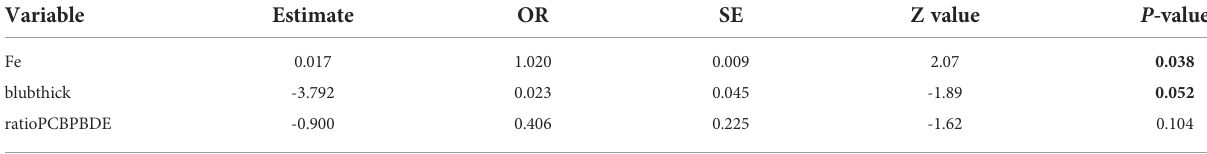
TABLE 2 Maximum-likelihood estimates and odds ratio (OR) from fi tting fi nal conditional logistic regression model for a case-control study, matched on age class, to evaluate variation in mucormycosis status (case or control) associated with iron (Fe), blubber thickness (cm) at necropsy (blubthick), and the ratio of the sum PCB/sum PBDE (ratioPCBPBDE) in harbor porpoise ( Phocoena phocoena ) in the Salish Sea. Variable